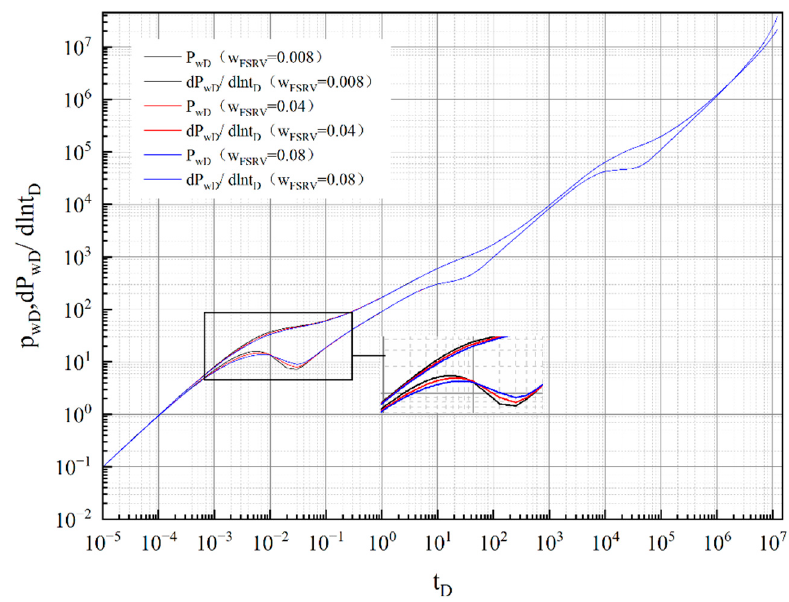
Figure 13. The effect of the FSRV storativity ratio on the pressure response.